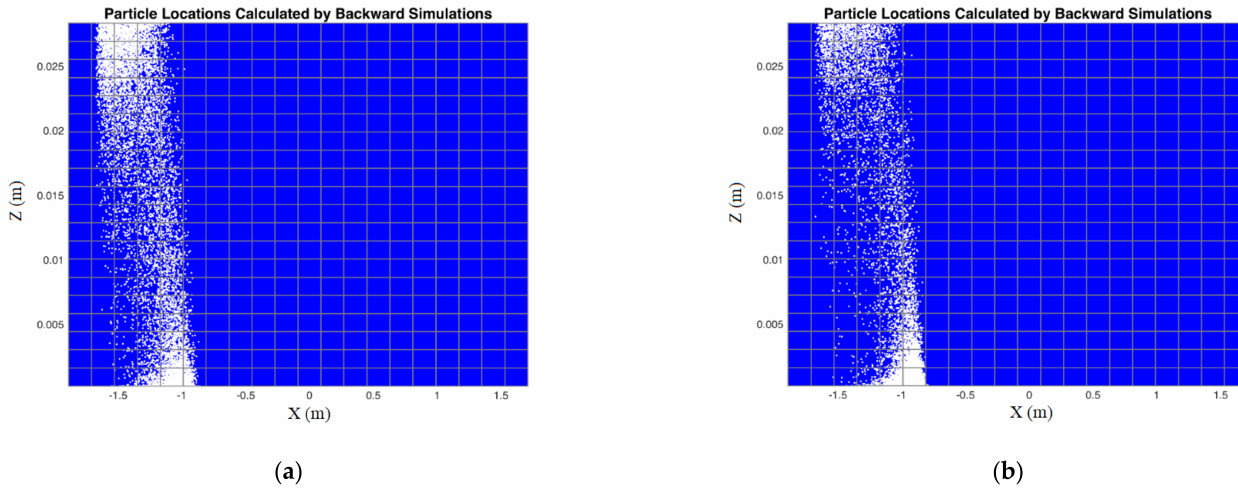
Figure 14. Particle locations calculated by backward simulations; ( a ) using explicit method; ( b ) using implicit